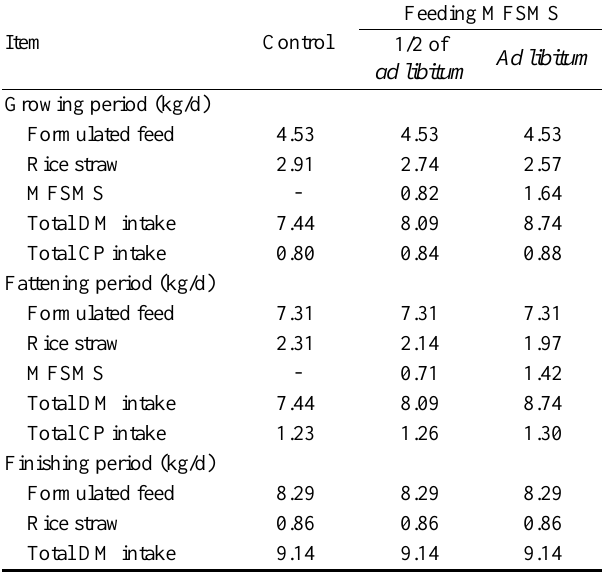
Table 2. Effect of dietary supplementation of microbially- fermented spent mushroom substrates (MFSMS) on feed intake of Hanwoo steers 1 Item